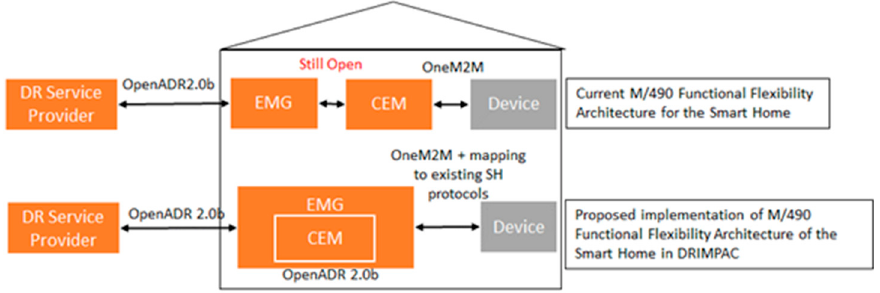
Figure 2. M/490 Functional Flexiblity Architecture and the DRIMPAC proposal to enable interoperability with existing Smart Home